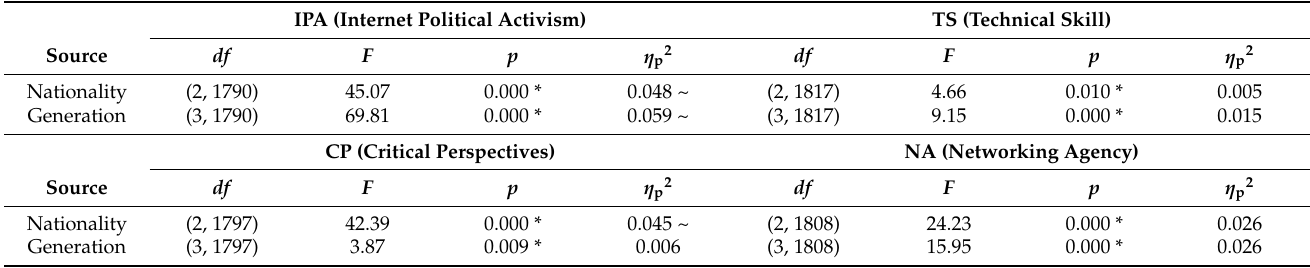
Table 6. Summary of ANOVA results of nationality and generation on DCS-R factors.